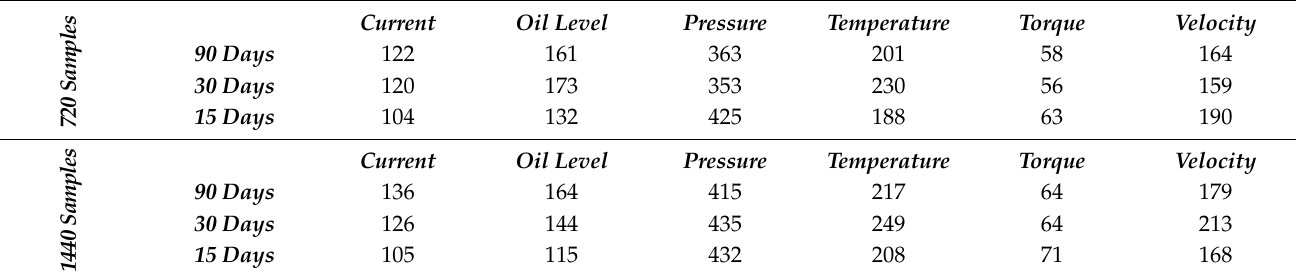
Table 3. Comparative number of